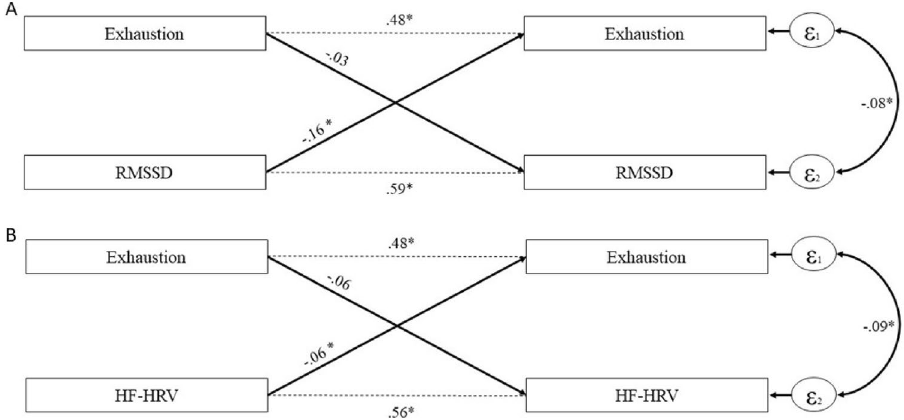
Figure 1. Cross-lagged associations between exhaustion symptoms and vagally-mediated heart rate variability. Illustration of the cross-lagged association between exhaustion symptoms and ( A ) RMSSD (root mean square of successive difference between heart beats, logarithmized), as well as ( B ) HF-HRV (high frequency heart rate variability, logarithmized), adjusted for sex, age, Body Mass Index, Patient Health Questionnaire 9—cognitive factor, Patient Health Questionnaire 9—somatic factor, smoking, alcohol consumption, and cardiovascular diseases. The numbers indicate unstandardized effect estimates which refer to logarithmized vmHRV values. T1 = first attended measurement time point; T2 = measurement time point with the largest time-lag to T1. *CI does not include zero.